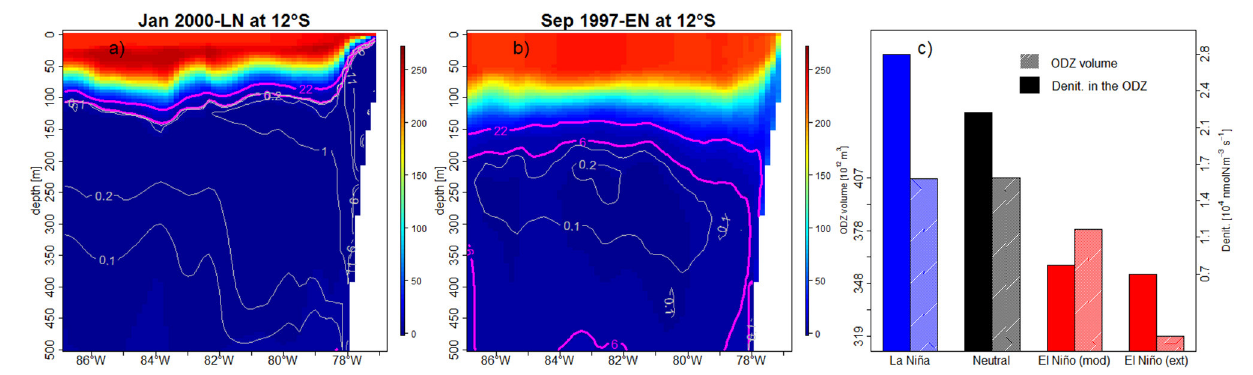
FIGURE 12 | Cross-shore vertical sections (12 ◦ S) of DO concentration (color shading and magenta lines, in µ mol O 2 kg − 1 ) and denitrification (gray lines, in 10 4 nmolN m − 3 s − 1 ) during the peak of 1997–1998 EN (a) and 1999–2000 LN (b) at 12 ◦ S. (c) WDC volume and mean denitrification during LN (blue bar), Neutral (black bar), moderate and extreme EN (red